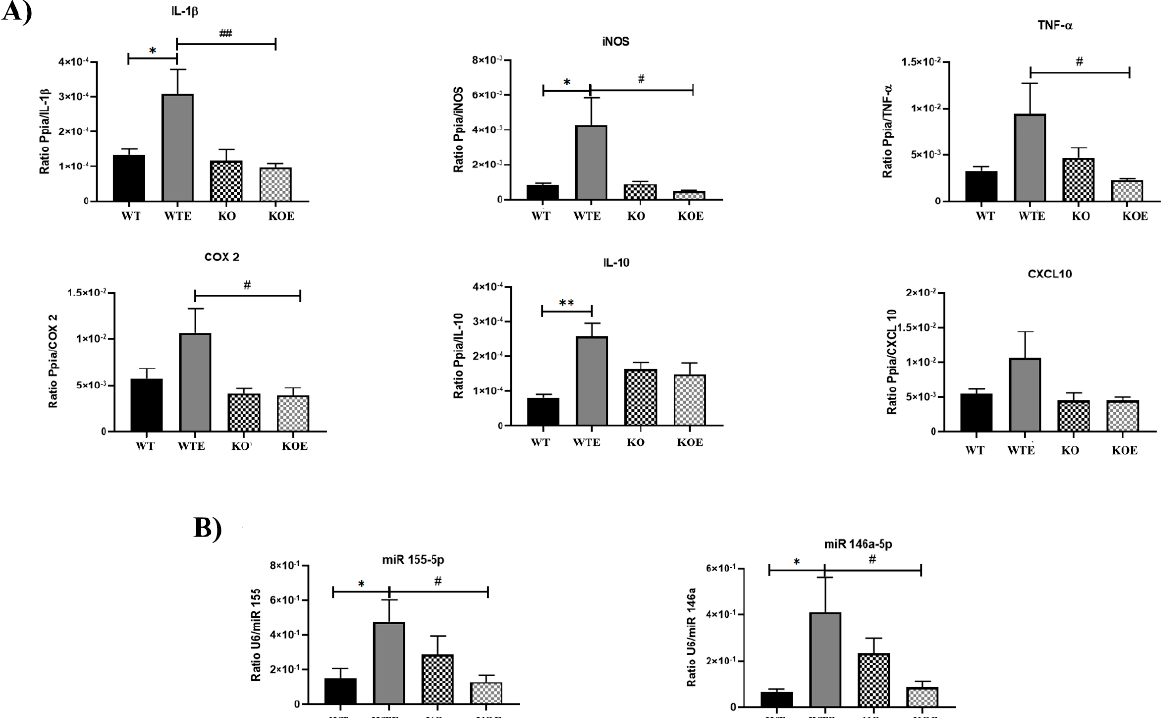
Figure 1. RT-qPCR differential expression analysis. The graphics represent the RT-qPCR comparisons made from the colons of the WT and TLR4-KO mice, with and without ethanol treatment. ( A ) Colon expression of the proinflammatory interleukin 1 β , enzyme iNOS , cytokine TNF- α , enzyme COX-2 , interleukin 10 , and chemokine CXCL10 mRNA levels. ( B ) Colon expression of the miR-155-5p and miR-146a-5p levels. * p < 0.05, ** p < 0.01 for treatment comparison purposes, and # p < 0.05, ## p < 0.01 for the genotype comparison according to one-way ANOVA and Tukey’s multiple comparisons test, except for CXCL10, according to the Kruskal–Wallis test and Dunn’s comparisons test. N = 6. Bars represent the mean ± SEM.